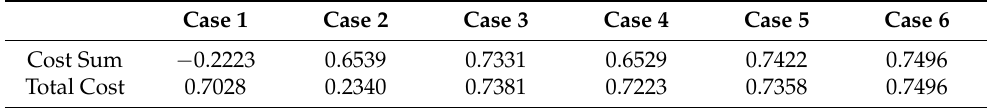
Table 4. R 2 average of Cost Sum and Total